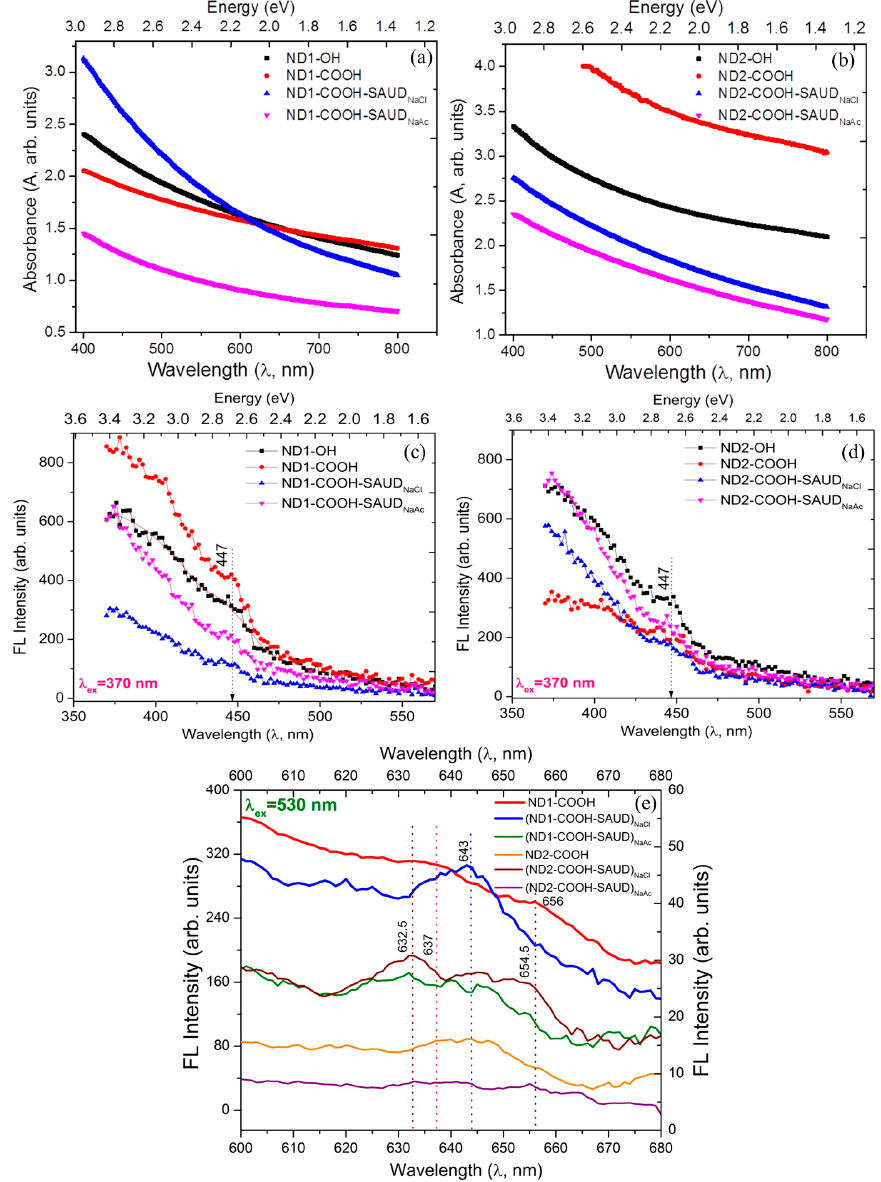
Figure 3. ( a , b ) UV-Visible optical absorption and ( c – e ) fluorescence spectra excited at λ L = 370 nm